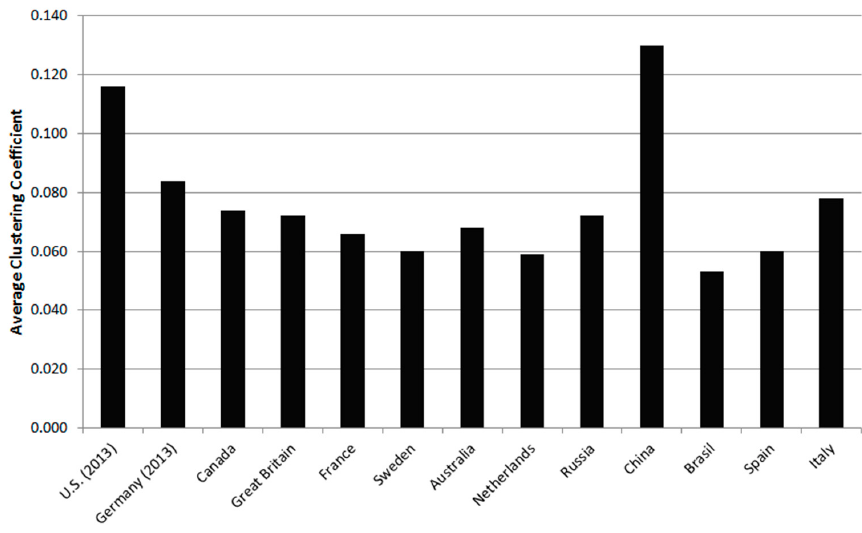
Figure 35. Average Clustering Coefficient per Country.